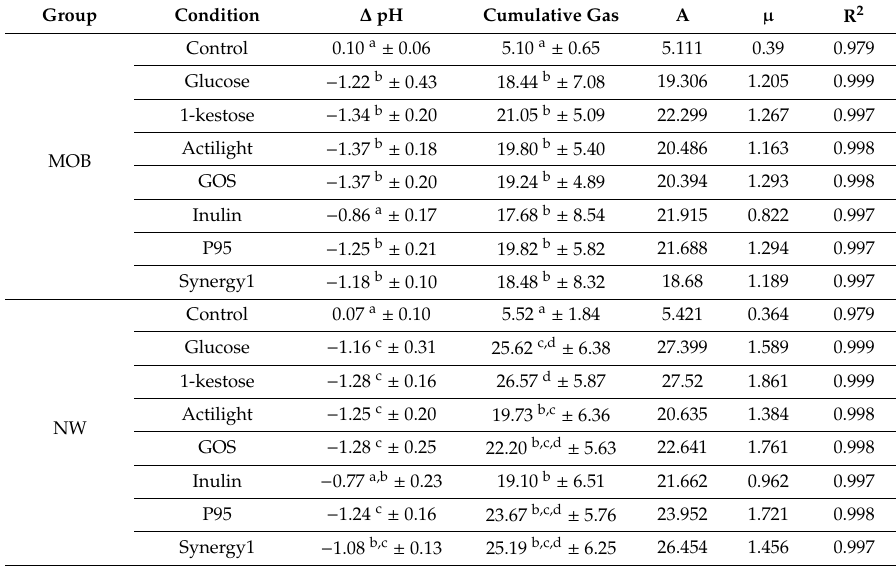
Table 1. Cumulative gas produced (mL) and decreases of pH values ( ∆ pH) after 24 h of incubation in fecal cultures with normal-weight (NW) and morbid obesity (MOB) microbiota. Kinetic parameters were determined using the modified-Gompertz equation, in which “A” represents the upper asymptote (mL) and “ µ ” is the rate of gas production (mL / h). The values not sharing the same superscript (a, b, c or d) indicate significant di ff erences ( p -value < 0.05) among carbon sources for each population group (NW or